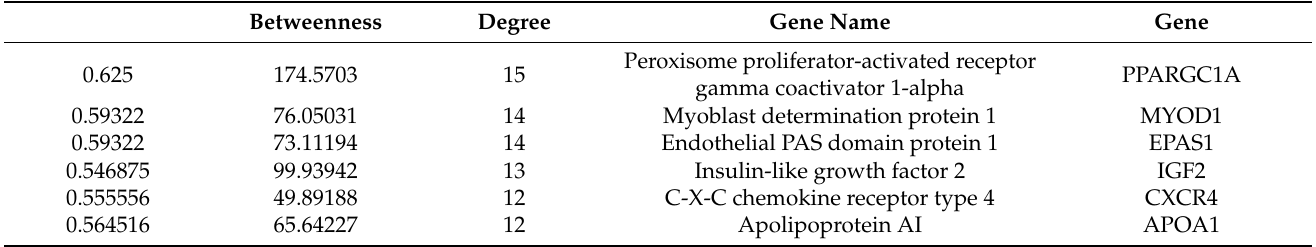
Figure 2. PPI network of differentially expressed genes of skeletal muscle in Bos taurus, Ovis aries , and Sus scrofa . DEGs—differentially expressed genes; Blue—downregulated DEGs; Red—upregulated DEGs. The node size is proportional to the degree bigger than 12. The bigger size of the node means a higher engagement of protein in the developmental process of skeletal muscle in Bos taurus, Ovis aries , and Sus scrofa . Table 11. Top six hub genes ranked by degree method in Bos taurus, Ovis aries , and Sus scrofa .